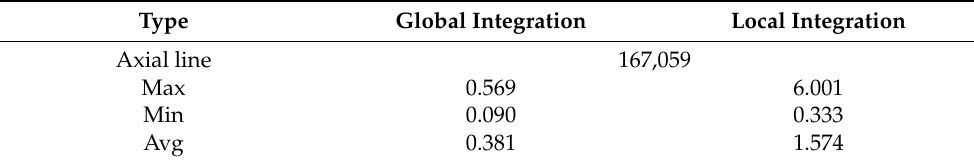
Table 4. Urban hierarchy actuality in Seoul.